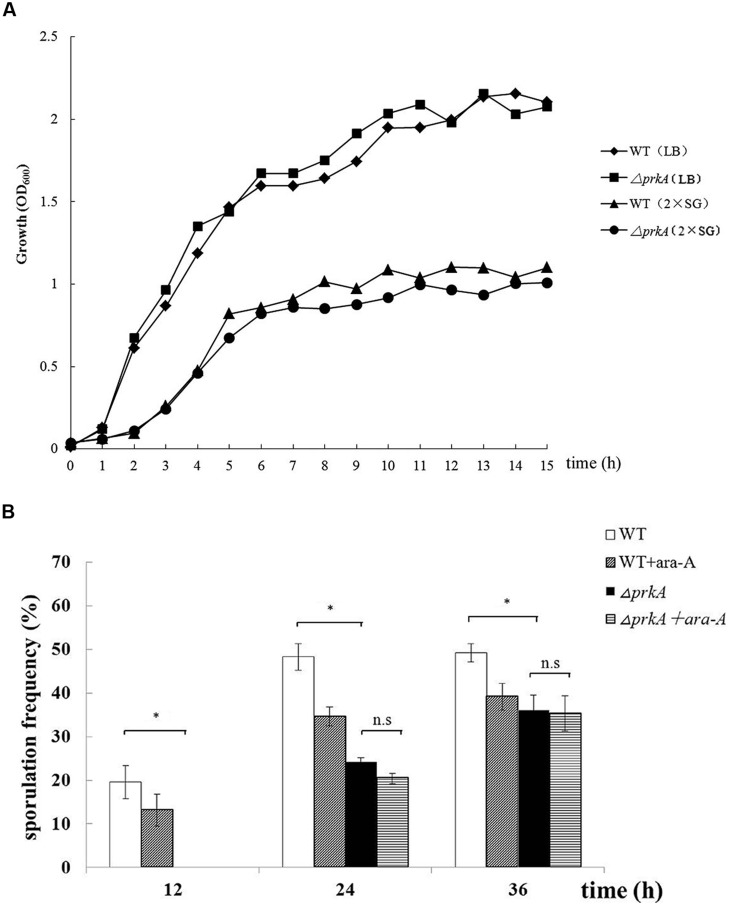
Disruption of the gene prkA decreases sporulation in B. subtilis 168. (A) The vegetative growth rates of ΔprkA mutant and B. subtilis 168 strain in either LB medium or 2x SG medium. ΔprkA mutant (■) and B. subtilis 168 in LB medium (◆); ΔprkA mutant (•) and B. subtilis 168 in 2x SG medium (▲). (B) Sporulation frequencies in WT strain B. subtilis 168, strain with ara-A, ΔprkA mutant strain, and ΔprkA mutant with ara-A. ∗P < 0.01; n.s represented no statistical significance.